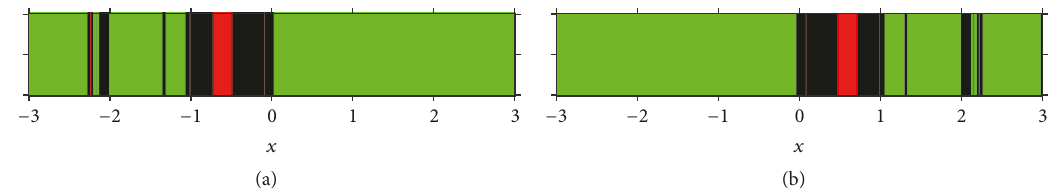
Figure 10: Dynamical lines of methods with (a) (𝛼,𝛾) = (−2.876, 1) and (b) (𝛼,𝛾) = (−2.876,−1) (red: 𝑥 ∗ 1 , green: 𝑥 ∗ 2 , blue: 𝑥 ∗ ∞ , and black: